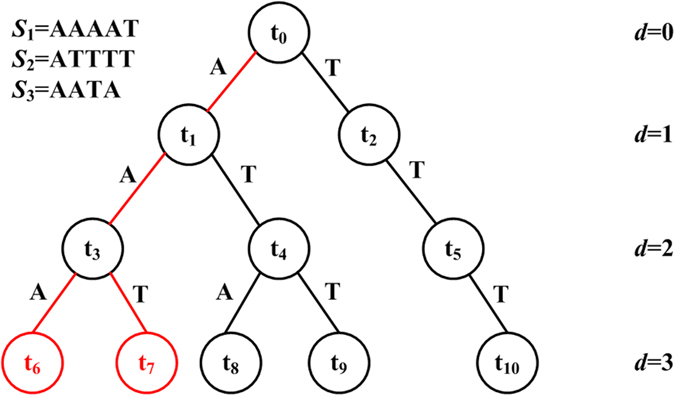
An example to show the tree structure of k-mer counting.This example only contains two alphabets, A and T. We use k = 3 and three sequences S1 = AAAAT, S2 = ATTTT, and S3 = AATA to build k-mer tree. Each node ti at depth d represents a sequence of length d, denoted by s(ti), which is determined by the path from the root of the tree to ti. At depth d = 3, for node t6, s(t6) = ‘AAA’, S1 contains two counts of this k-mer, S2 and S3 do not contain this k-mer. For node t7, s(t7) = ‘AAT’, S1 and S3 both contain one count, and S2 does not contain this k-mer. Compared t6 with t7, the paths to these two nodes only contain one mismatch.